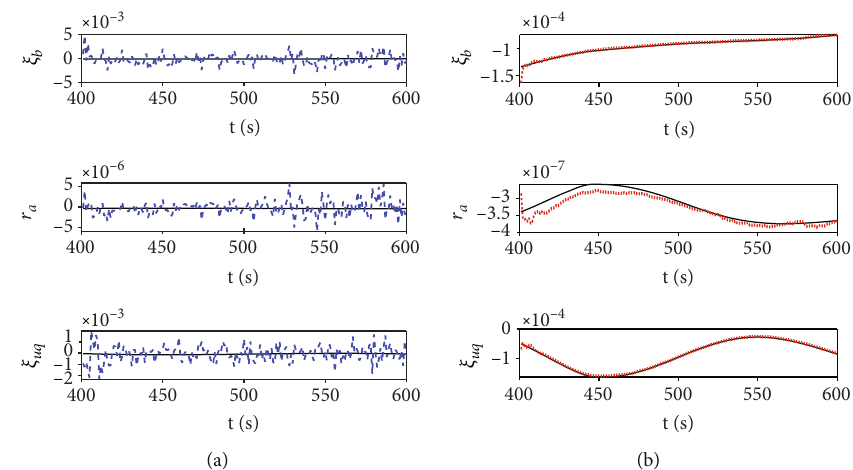
Figure 9: Result of parameter modi fi cation network. (a) is the variation of fi ltering maneuver parameters. (b) is the variation of fi ltering maneuver parameters.